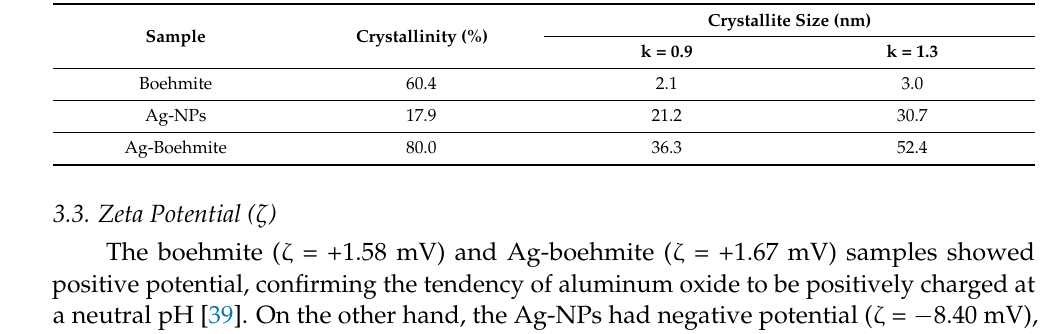
Table 3. Crystallinity parameters (percentage and size) calculated from XRD.